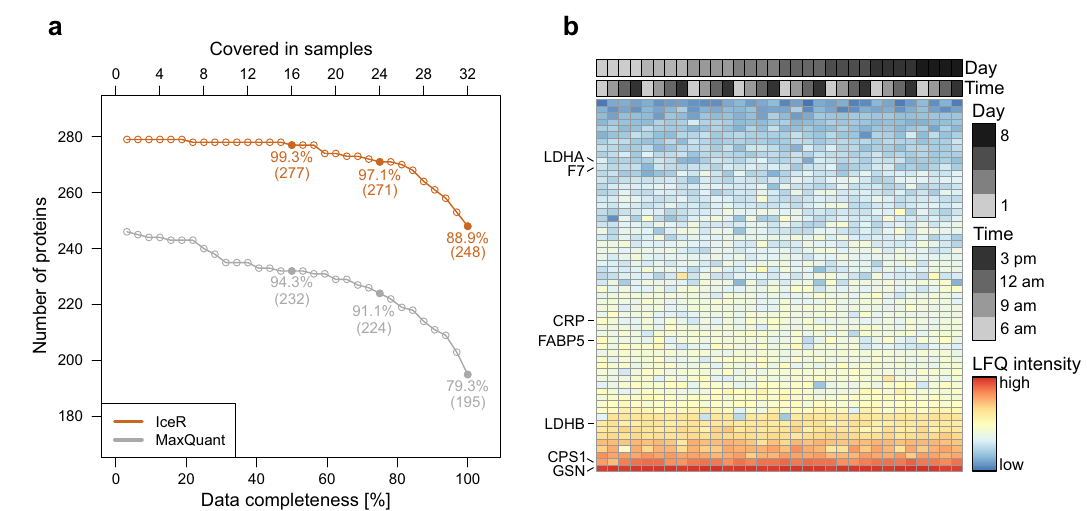
Fig. 6 Application of IceR to a plasma proteomics data set. a Numbers of fully quanti fi ed proteins with an increasing number of samples for MaxQuant (grey) and IceR (orange) in plasma proteomics analyses of 32 fi nger prick samples acquired from one person over 8 consecutive days. Relative fractions of fully quanti fi ed proteins at 50%, 75% and 100% data completeness are highlighted. b LFQ intensities of proteins without missing values in IceR but incomplete quanti fi cation in MaxQuant. Samples are ordered per sample acquisition day and time. Colours indicate protein abundance estimations. Seven important plasma protein markers are